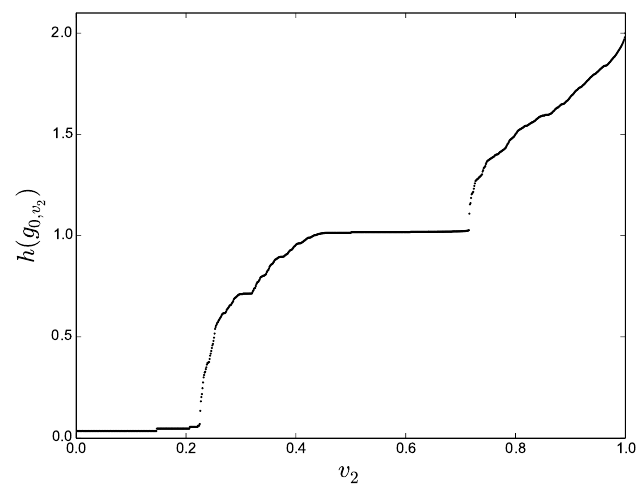
Fig. 6 Plot h ( g 0 , v ) in bits vs v 2 , 0 < v 2 ≤ 1 ( ε = 10 − 4 , ∆ v 2 = 0 . 001). 2